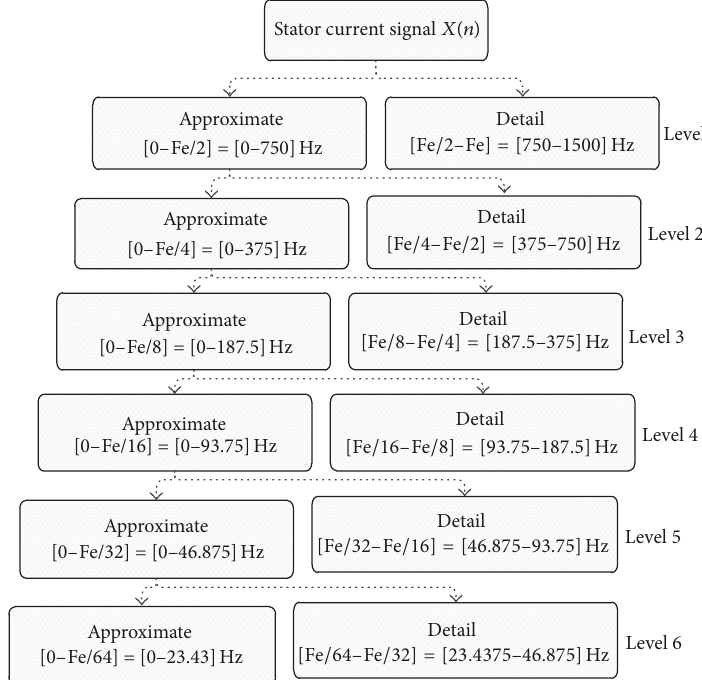
Figure 5: Decomposition of stator current signal 𝑥(𝑡) .